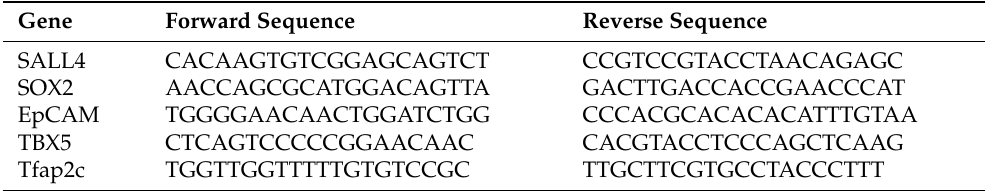
Table 1. Gene specific primer pairs (5 (cid:48) to 3 (cid:48) ).